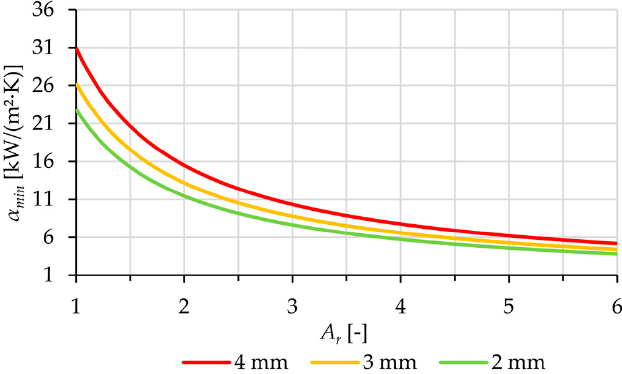
Figure 6. α min as a function of area ratio A r and tungsten shell Figure 6. 𝛼 (cid:3040)(cid:3036)(cid:3041) as a function of area ratio A r and tungsten shell thickness.